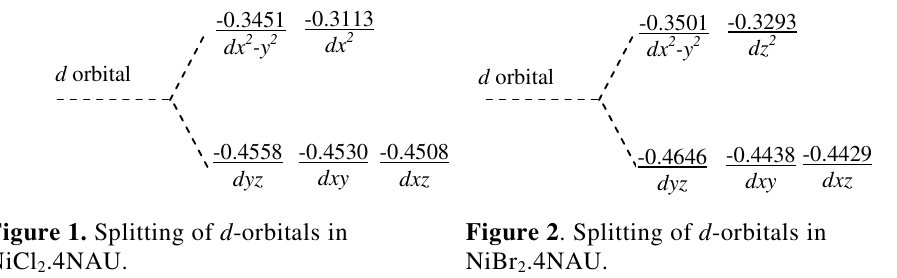
Figure 2 . Splitting of d -orbitals in NiBr 2